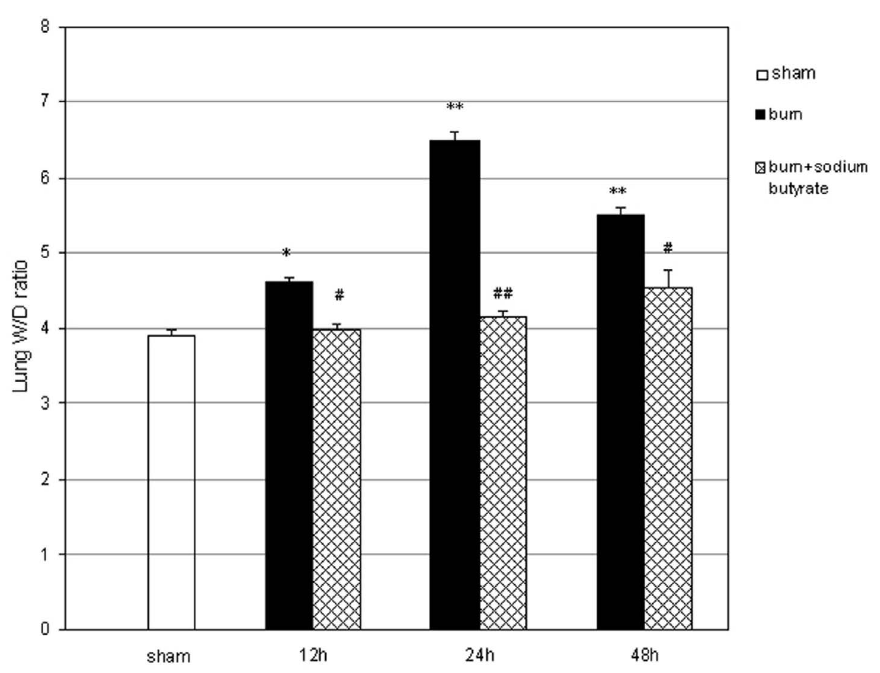
Figure 4. Effect of sodium butyrate on pulmonary edema after burn injury. The lung W/D ratios were calculated to evaluate lung edema. The 30% TBSA full-thickness burn resulted in a significant increase in lung W/D ratios, which were attenuated by the sodium butyrate treatment. Results are given as mean 6 SEM (n=8). *p , 0.05, **p , 0.01, vs. sham, ANOVA; # p , 0.05, ## p , 0.01, vs. related burn group, ANOVA.